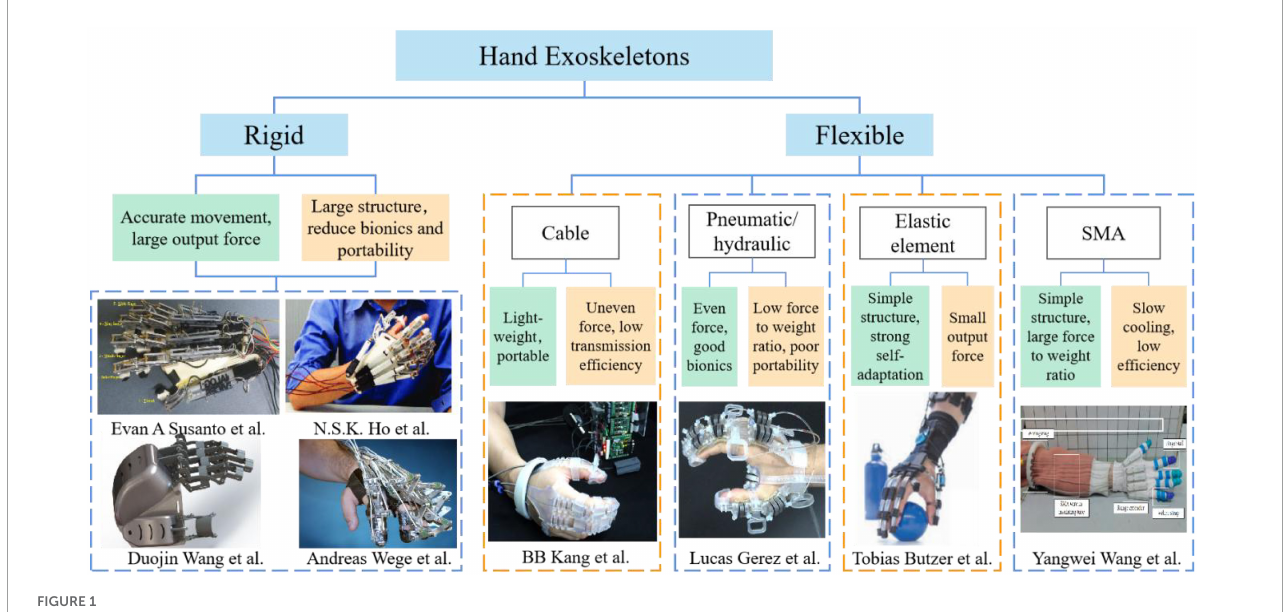
FIGURE1 The state of hand